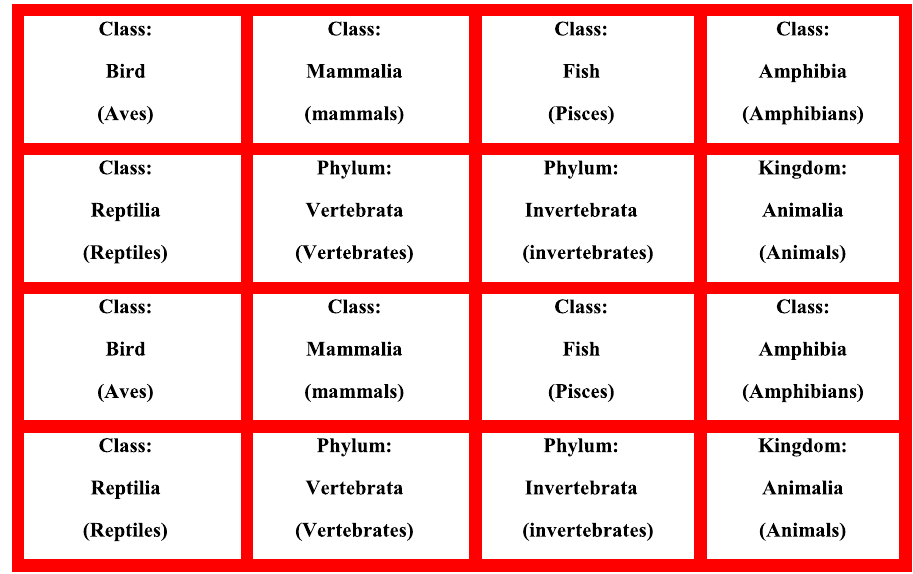
Fig. 4. Bingo First Series: bingo card kingdom, phyla and classes of vertebrates.